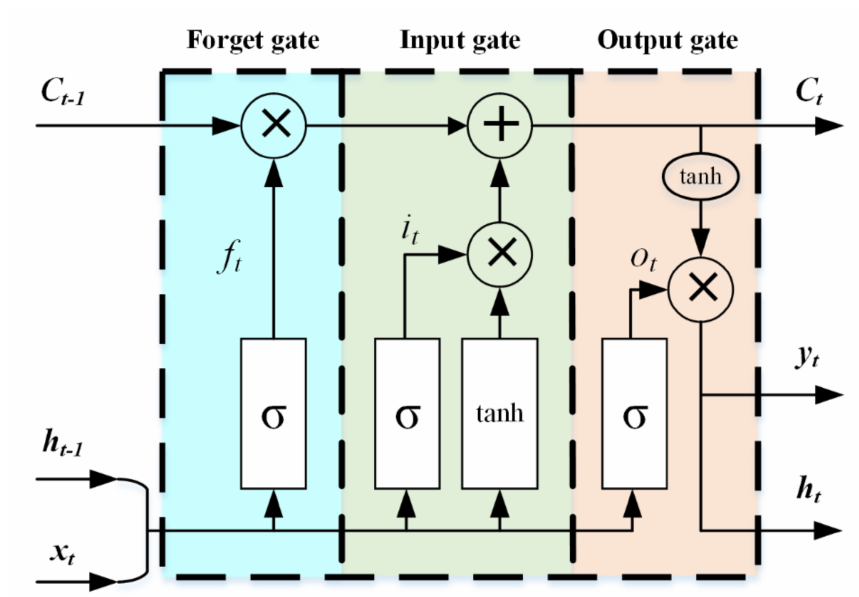
Figure 4. LSTM cell